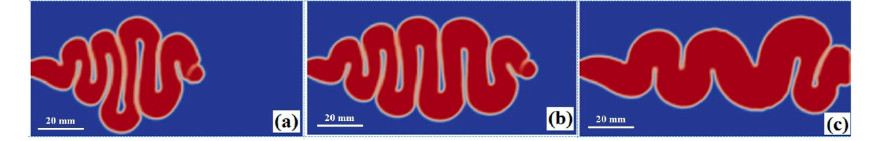
Figure 3. The buckling flow evolution varies with injection speeds of ( a ) 100 mm/s ( t = 1.85 s); ( b ) 200 mm/s ( t = 1.35 s); and ( c ) 300 mm/s ( t = 0.95 s).